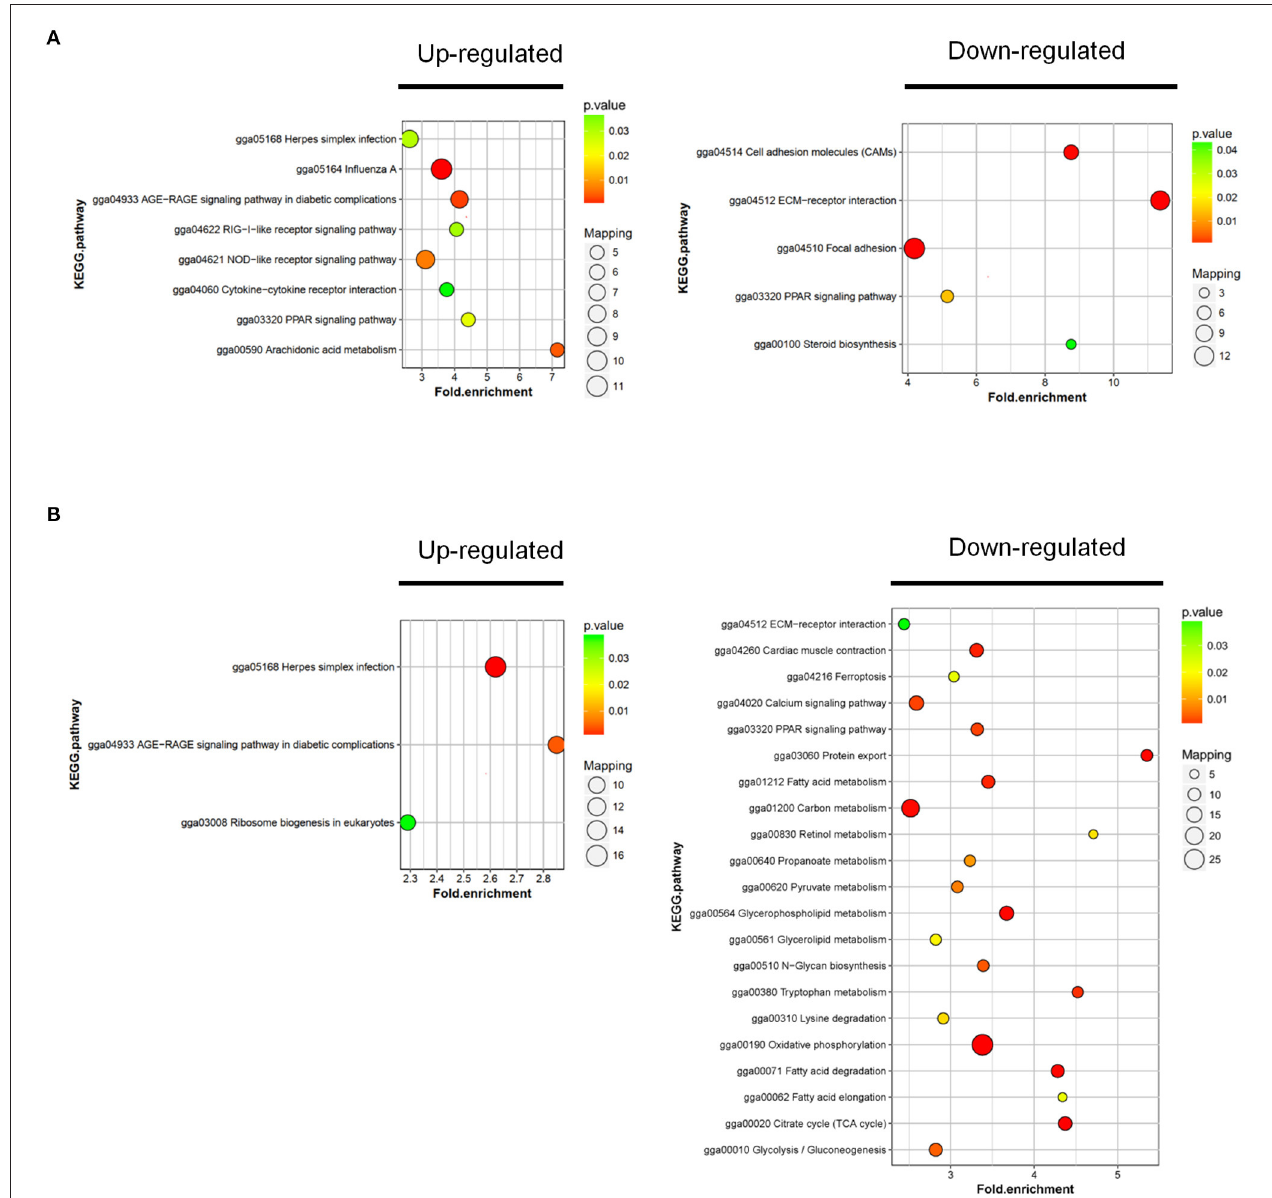
FIGURE 5 | KEGG cluster and pathway enrichment analysis of DAPs. Statistics of KEGG enrichment in RM vs. M (A) and RM vs. R (B) . The pathway enrichment statistical analysis was performed by Fisher’s exact test. The x-axis is folded enrichment; the y-axis is enrichment pathway. The mapping is the protein number. The color indicates the significance of the enrichment ( p -value). The darker the color, the more significant the enrichment of the pathway. R, REV-infected CEF cells; M, MDV-infected CEF cells; RM, REV and MDV coinfected CEF cells. KEGG, Kyoto Encyclopedia of Genes and Genomes; DAPs, differentially accumulated proteins; REV, reticuloendotheliosis virus; MDV, Marek’s disease